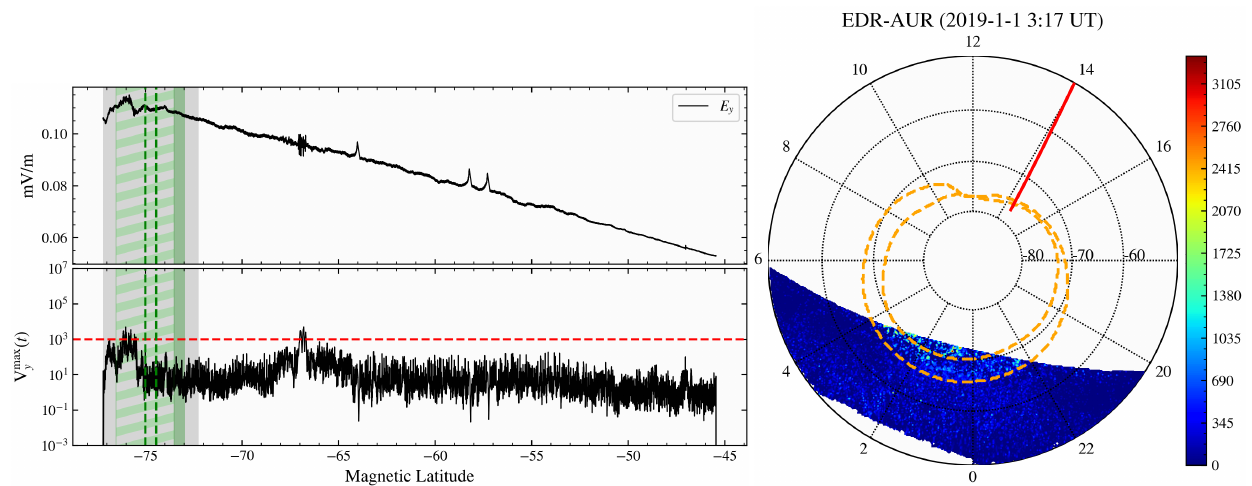
Figure 10. Same as Figure 7, except for orbit 5060. Negative detection, dayside southern hemisphere. As a last example for the sourhern hemisphere, in Figure 11 we report another false positive detection on the dayside. Here, the AOD algorithm identifies an active interval between − 66.8 ◦ and − 68.6 ◦ magnetic latitude. It is indeed plausible that the real equator- ward boundary of the AO is located at a lower latitude than the one given by GUVI fits. However, it is highly unlikely that the actual boundary is located at a much lower latitude.